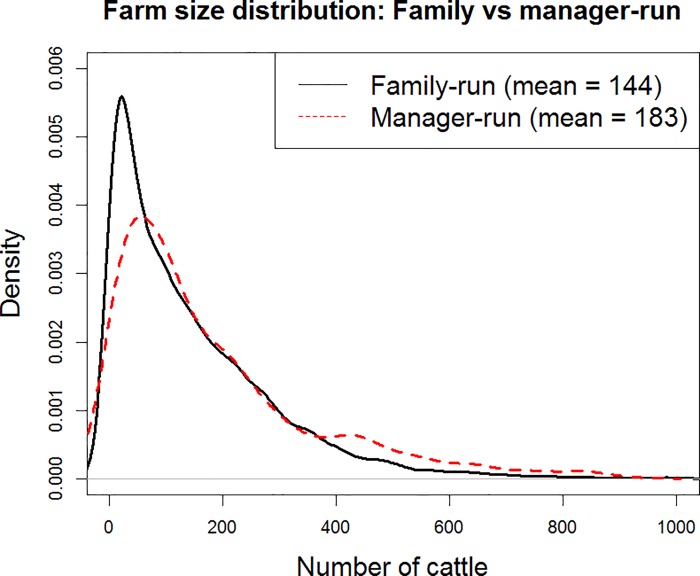
Farm size distribution (density) between family and manager-run farms; family-run farms have more farms with fewer cattle and fewer farms with more cattle than do manager-run farms.